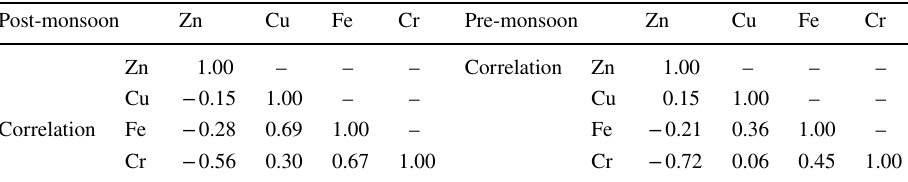
coefficients of heavy metals during pre- and post-monsoon months, 2013–14